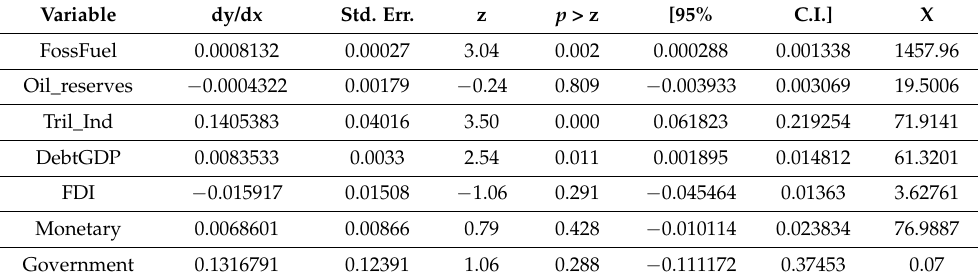
Table 9. Marginal effects after the multinomial probability